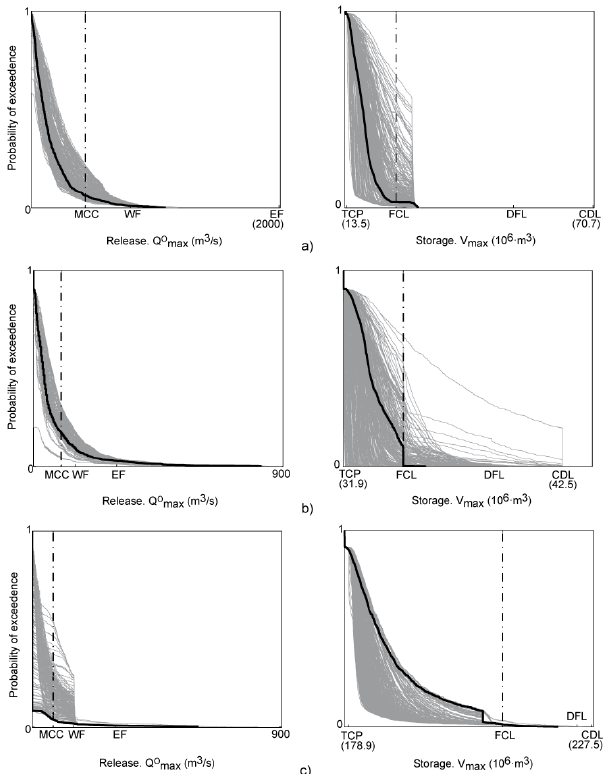
) and their bearing in 802 Ir shows the aptest balance 804 Ir